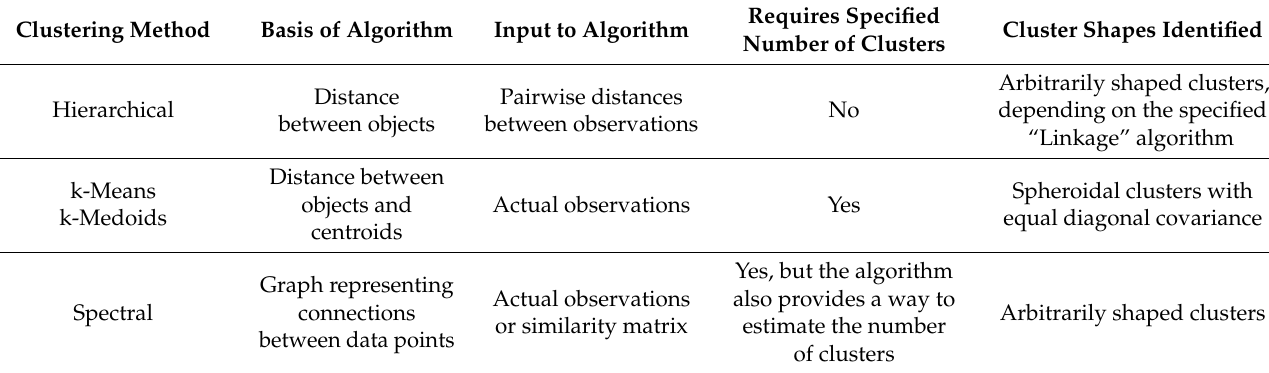
Table 2. Comparison of the main characteristics of the clustering algorithms